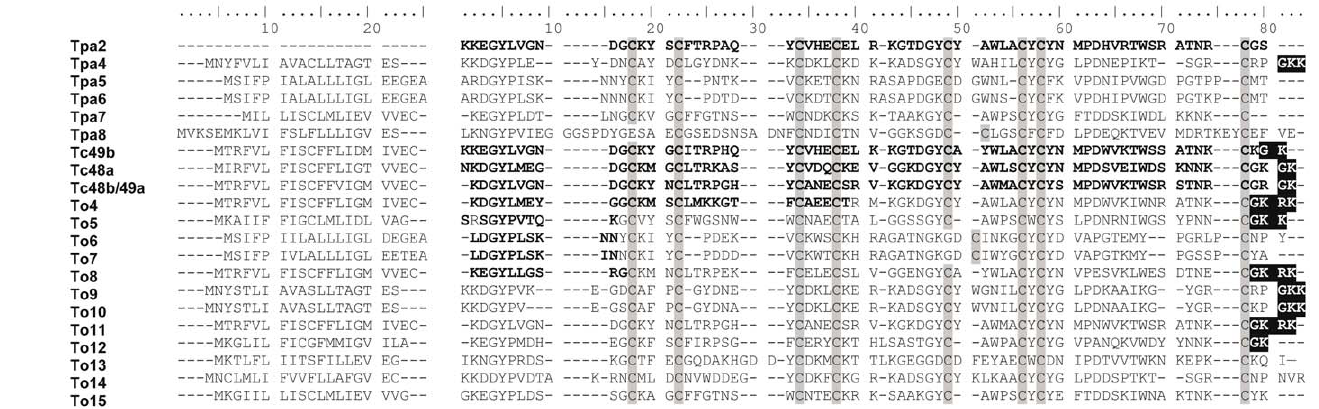
Figure 1. Multiple sequence alignment of Sodium-channel toxins from T.pachyurus (Tpa) and T.obscurus (To). The amino acid sequences already described in literature are showed in bold. Predicted amino acid sequences are shown with the putative signal peptides in the left and the putative mature toxins in the right, with the identified C-terminal prosequences shaded in black. Cys residues from the mature peptides are shaded in grey.